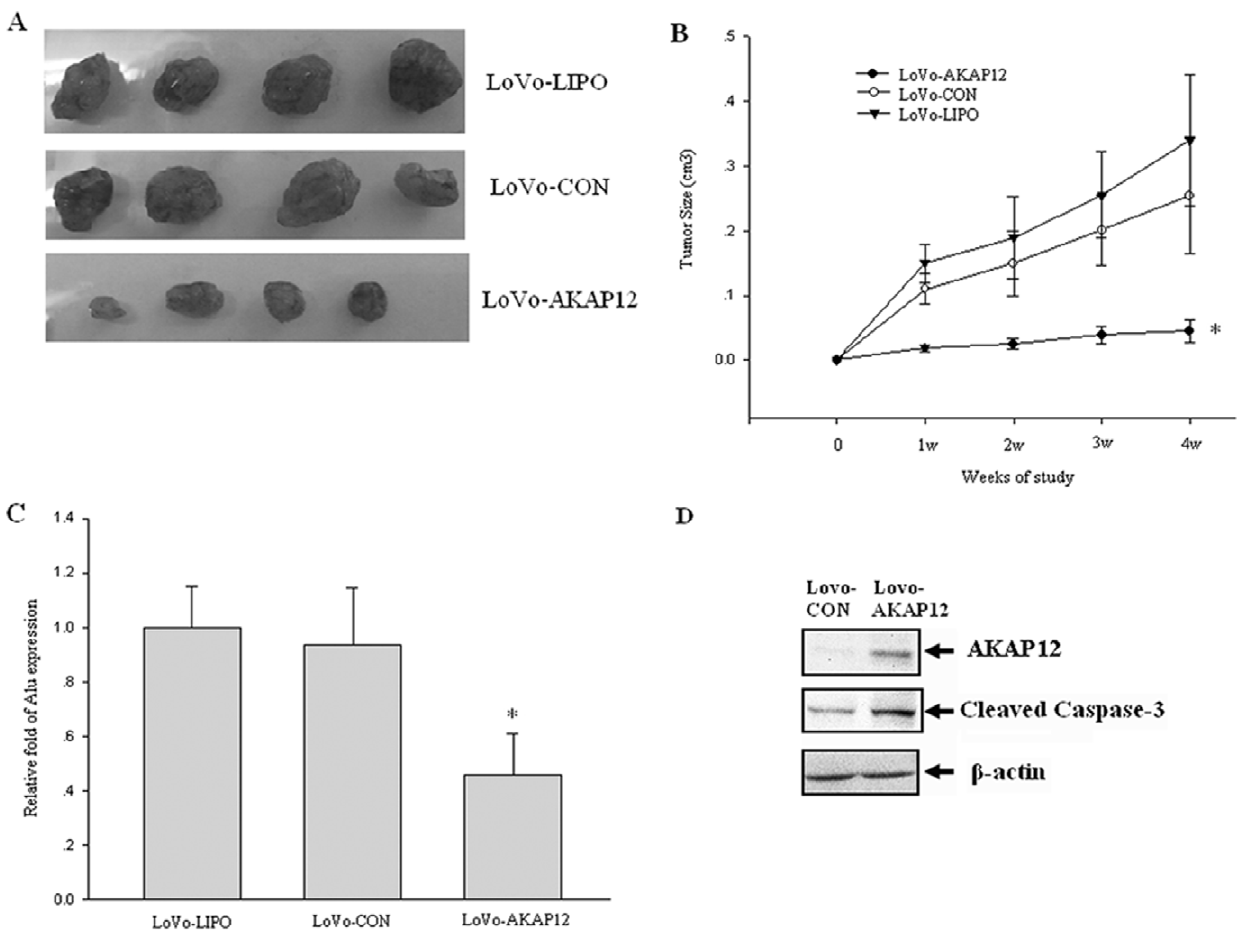
Figure 3. The effect of AKAP12 on the growth of human primary xenografts. (A) AKAP12 suppresses the growth of LoVo cells implanted in BALB/c nude mice. Mice injected with LoVo-AKAP12 cells displayed significantly reduced tumor volume compared with the animals injected with LoVo-CON or LoVo-LIPO cells four weeks after injection. (B) Tumor size was measured every week. Each point represents the mean volume 6 SD on the X-axis. * p , 0.01, LoVo-AKAP12 versus LoVo-CON versus LoVo-LIPO. p , 0.01, LoVo-AKAP12 versus LoVo-CON. (C) Effect of AKAP12 expression on the spontaneous metastasis of LoVo cells in nude mice. The quantitative real-time PCR amplification of the human Alu sequence and mouse GAPDH was performed using DNA extracts from the lung. (D) Western blot analysis of AKAP12 and cleaved-caspase-3 level in Lovo-CON and Lovo-AKAP12 group. AKAP12 and cleaved-caspase-3 were found to increase in the Lovo-AKAP12 group.